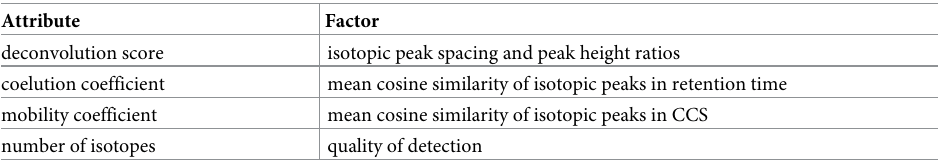
Table 1. Feature attributes used for identifiability classifier